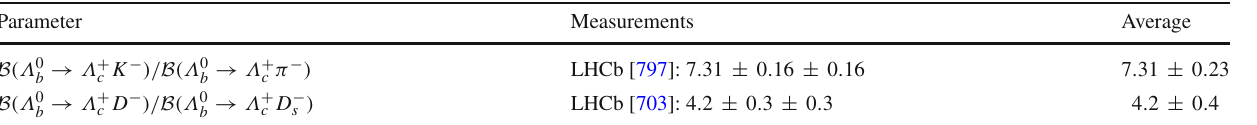
Table 215 Relative decay rates to Λ c II [ 10 − 2